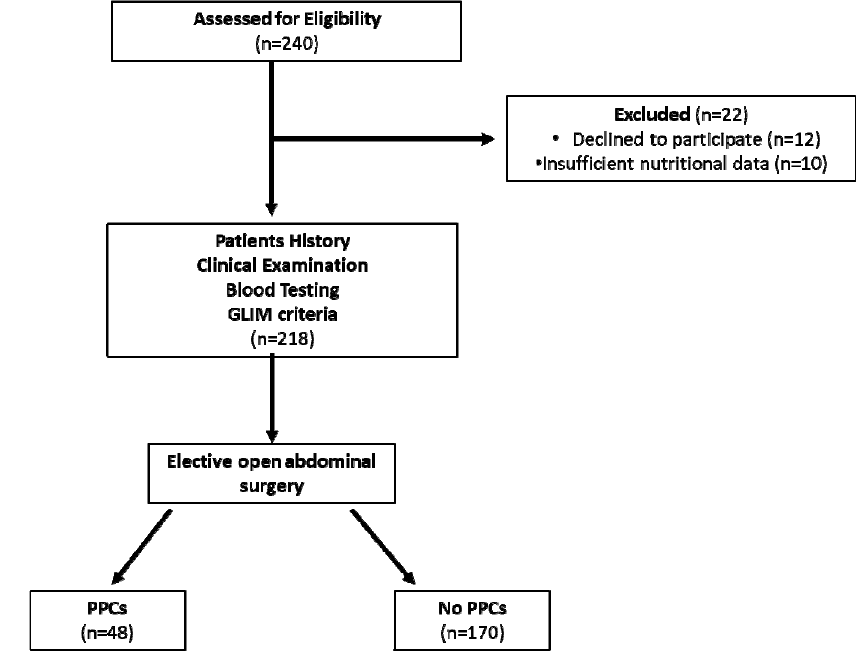
Figure 1. Flowchart of enrolled patients. GLIM, Global Leadership Initiative on Malnutrition; PPCs, postoperative pulmonary complications.